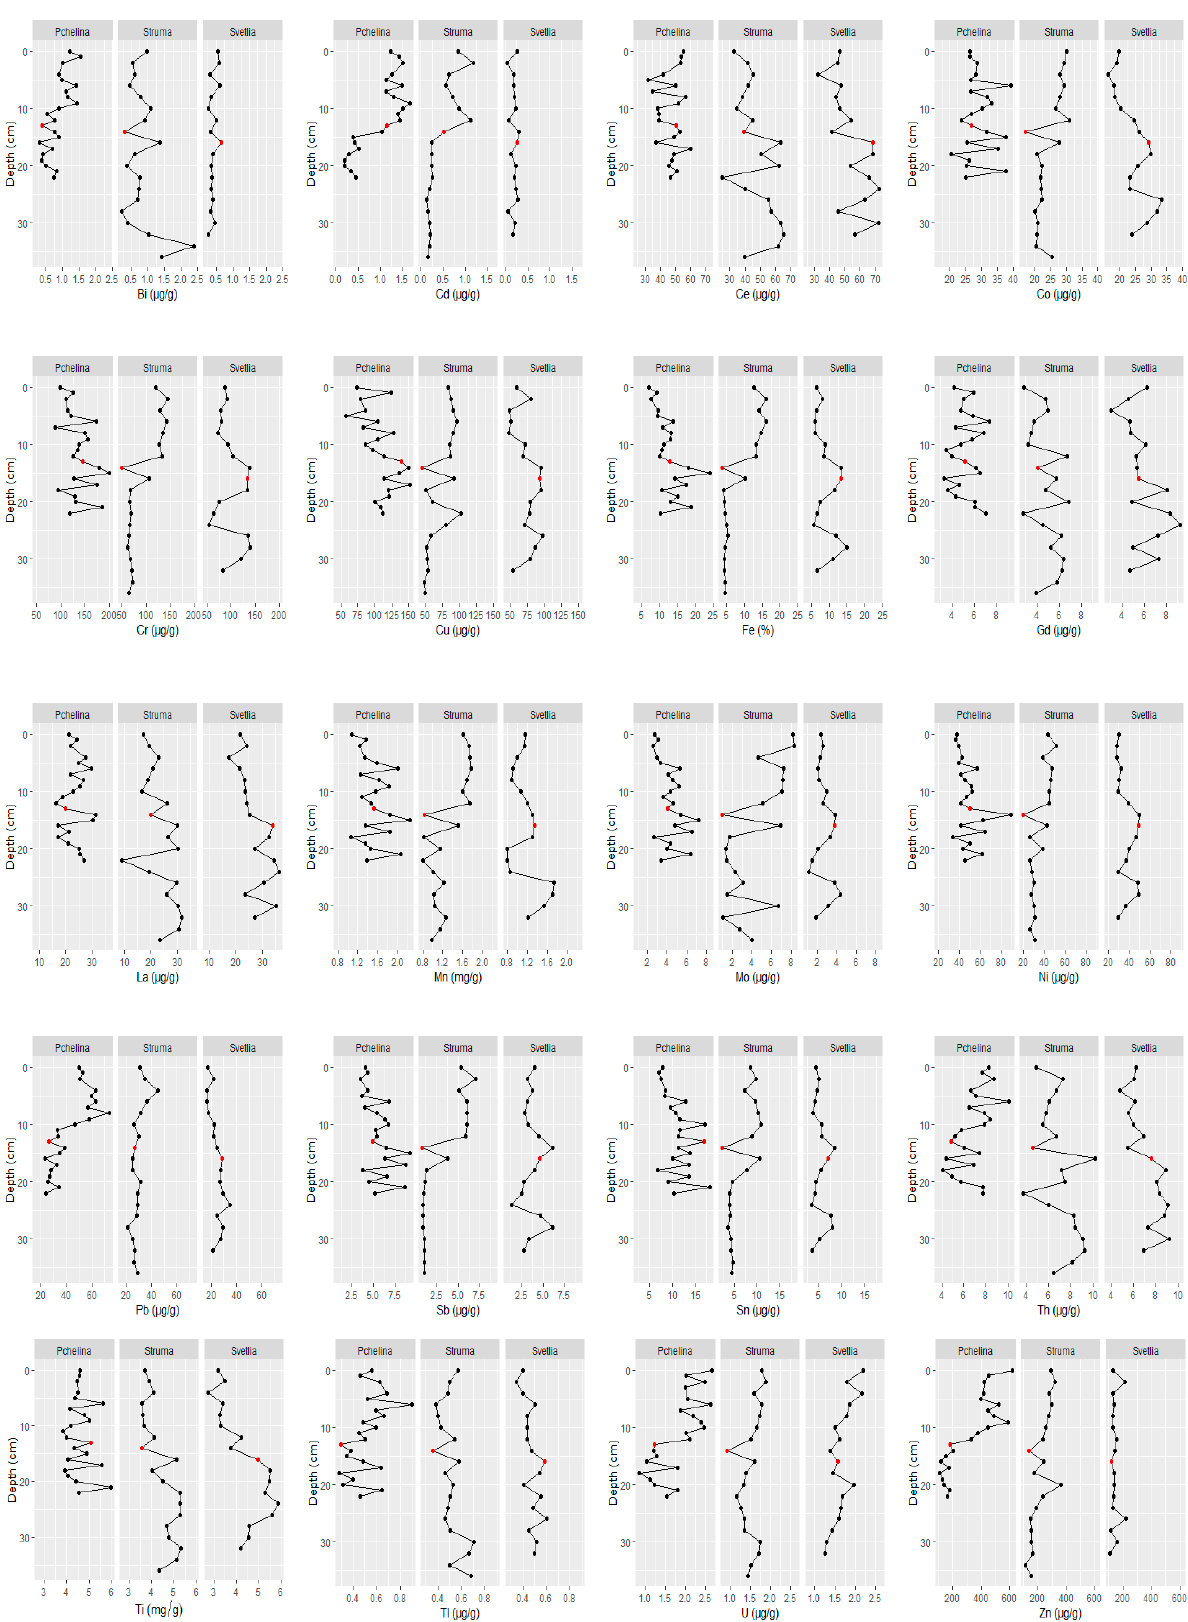
Figure 4. Elements’ depth profiles of sediment cores taken at Pchelina, Struma and Svetlia. To determine whether significant time trends of elements were observed, the Mann– Kendell test was performed. The results are presented in Table 1, with significant trends ( p < 0.05) marked with “+” for increasing and “ − ” for decreasing trends. The significant time tendencies in the sediment cores influenced by the flowing rivers reveal that Struma River (sampling point 1) is the main source of Pchelina Reservoir pollution. Table 1. Trend analysis of sediment cores at three sampling points. Element